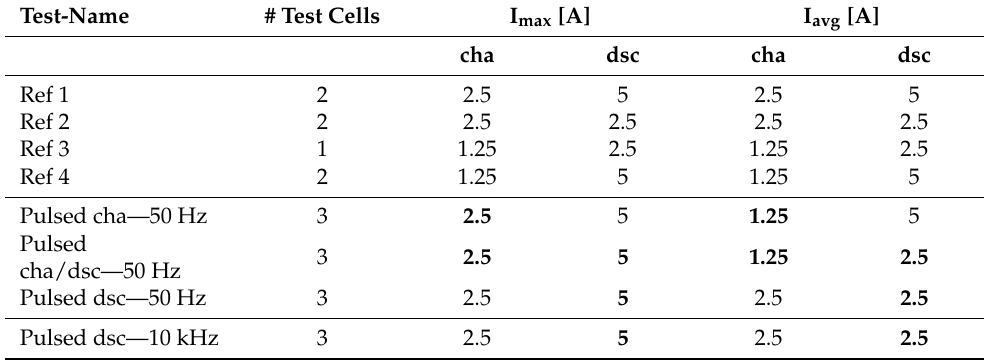
Table 2. Test matrix.